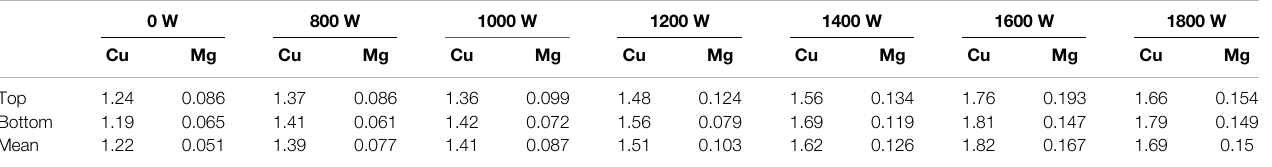
TABLE 2 | Distribution of Cu and Mg content in grains of 2195 Al – Li alloy ingots at typical positions under different power conditions (wt%). 0